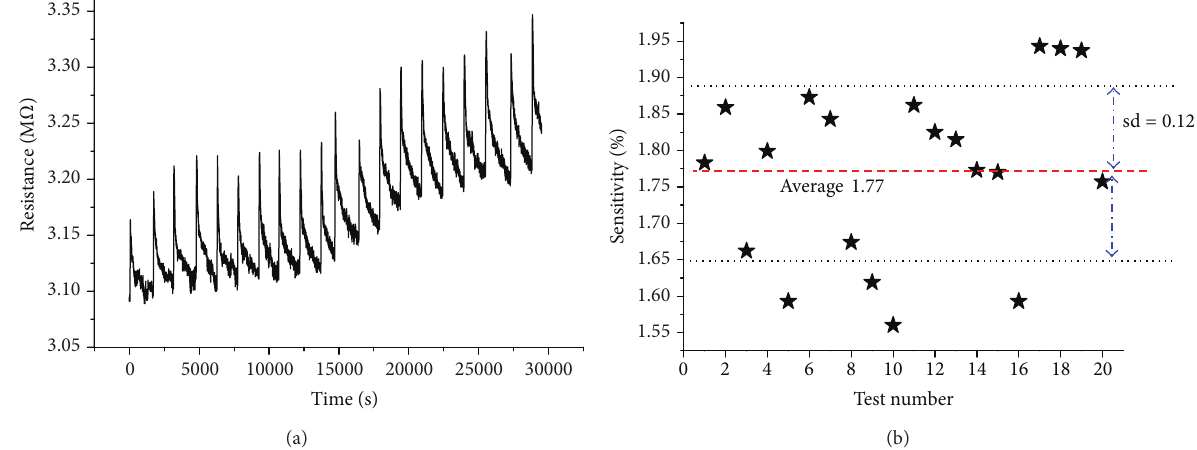
Figure 4: For the MST-3a sample: (a) MST experiment to 0.1mL THF and (b) reproducibility to the MST experiment at 0.1mL THF.